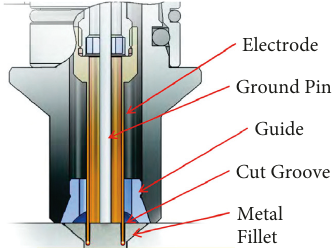
Figure 1: Schematic of typical hole drilling EDM